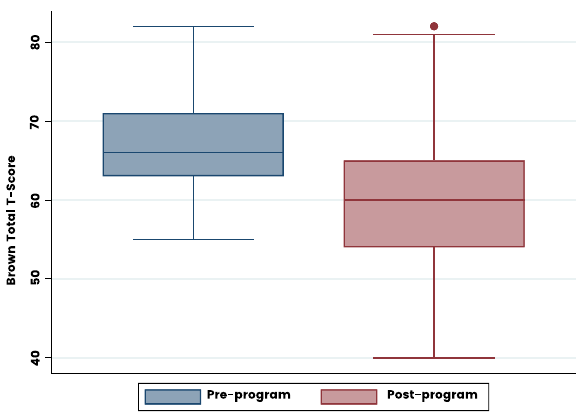
Fig. 1 Change in Brown Attention-De fi cit Disorder Scales (BADDS) scores from pre- to post-Brain Balance (BB) program. The dot indicates a signi fi cant difference in BADDS total T-scores from pre-program (blue) to post-program